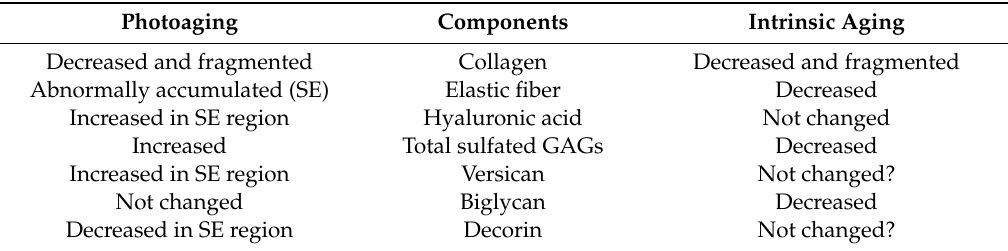
Table 1. Changes in dermal extracellular matrix components in the aging process. Photoaging Components Intrinsic Aging Decreased and fragmented Collagen Decreased and fragmented Abnormally accumulated (SE) Elastic fiber Decreased Increased in SE region Hyaluronic acid Not changed Increased Total sulfated GAGs Decreased Increased in SE region Biglycan Decorin GAG = glycosaminoglycan, SE = solar